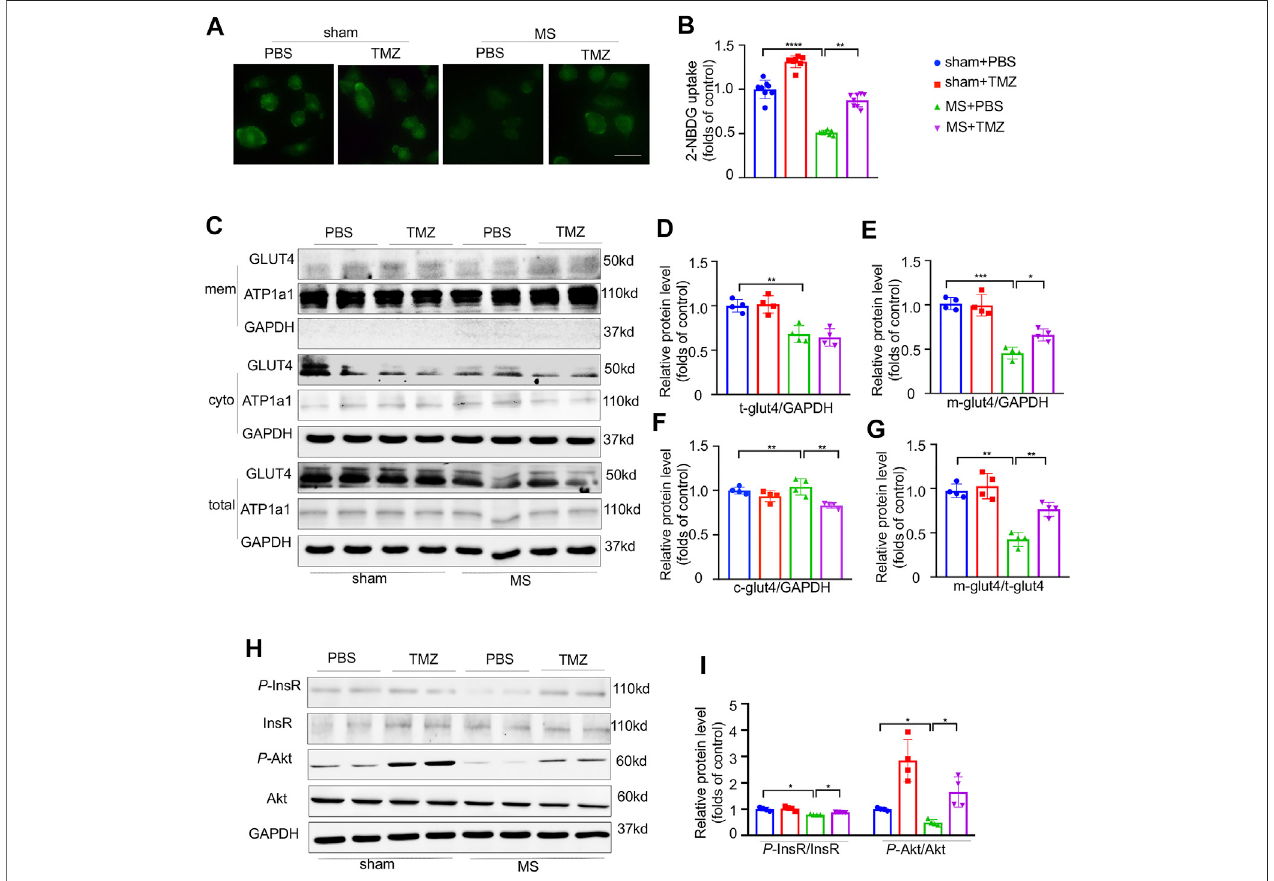
FIGURE 5 | Pressure overload-induced impairment of insulin signaling was preserved by Trimetazidine in vitro . (A,B) The representative 2-NBDG fl uorescence images and its quantitative analysis of H9C2 cell line. Scale bar (cid:2) 100 um. (C – G) Representative GLUT4 western blots in NRCMs and correspondence quantitative analysis, Na-K-ATPase wasused asthe membrane loading control, and GAPDH for cytoplasm loading control. M-GLUT4, GLUT4 inthe membrane. C-GLUT4, GLUT4 inthecytoplasm.T-GLUT4,totalGLUT4. (H,I) TheproteinlevelsofInsR,Aktandtheirphosphorylationstates.Graphicaldataareshownasmean ± SEM.Two-way ANOVA was used for analysis. * p < 0.05, ** p < 0.01, *** p < 0.001, **** p < 0.0001, vs indicated group. MS, Mechanical stretch; TMZ,